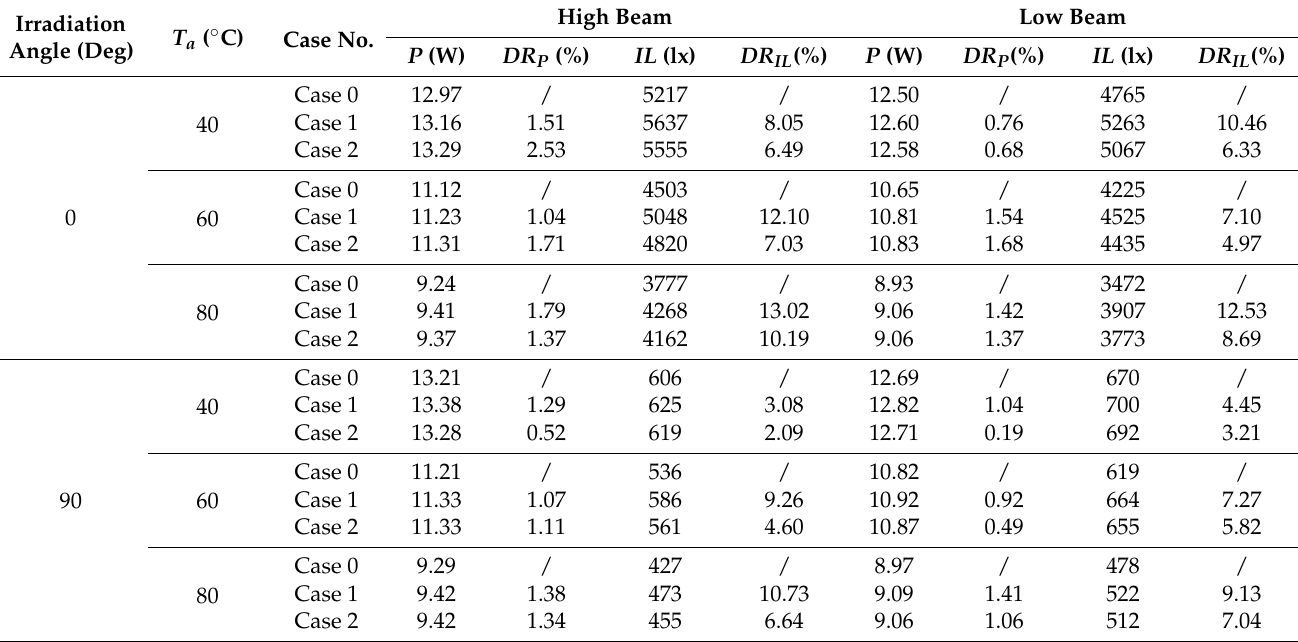
Table 1. Experimental results of P and IL of automotive LED lamps